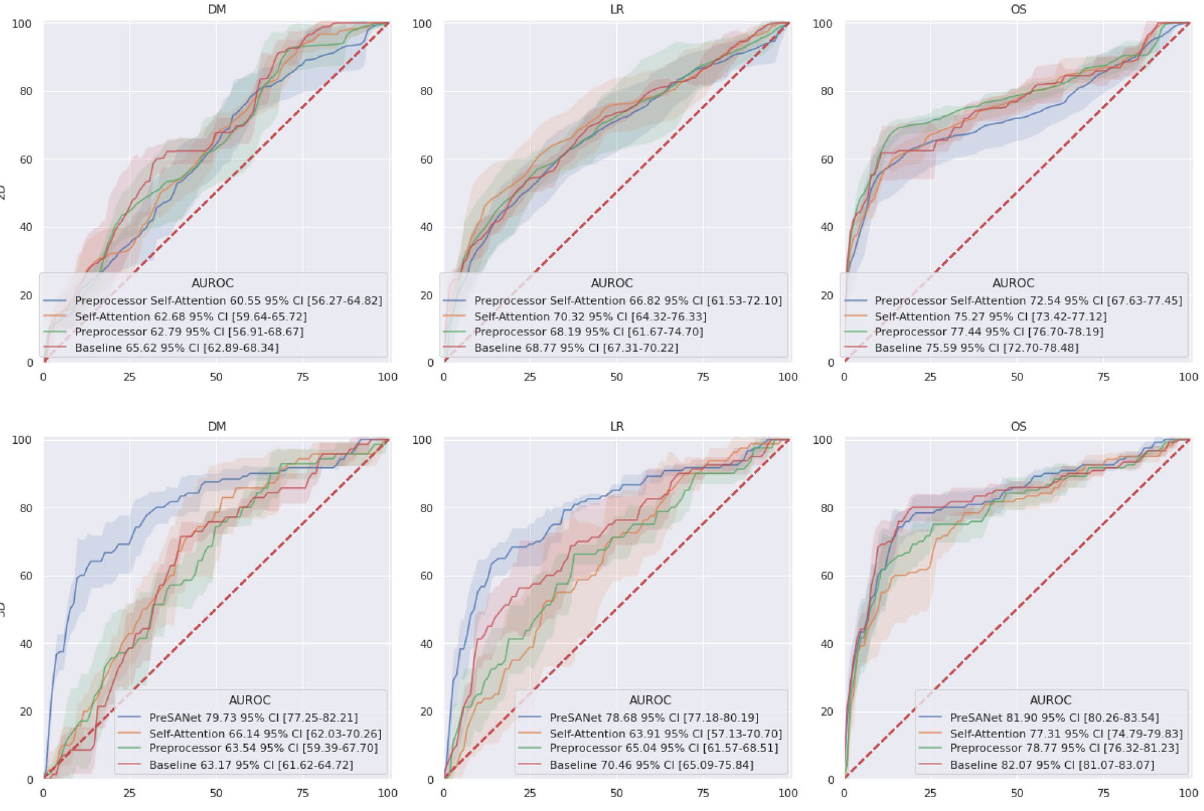
Figure 1. ROC curves for the proposed PreSANet model with different feature ablation. Rows represent the baseline 2D and the proposed pseudo-3D architectures. Figures presented are mean AUC [ 95% CI] over 5 trials. Training and validation split used is shown in Fig. 8A 30 . Figure created with seaborn/matplotlib v0.11.2